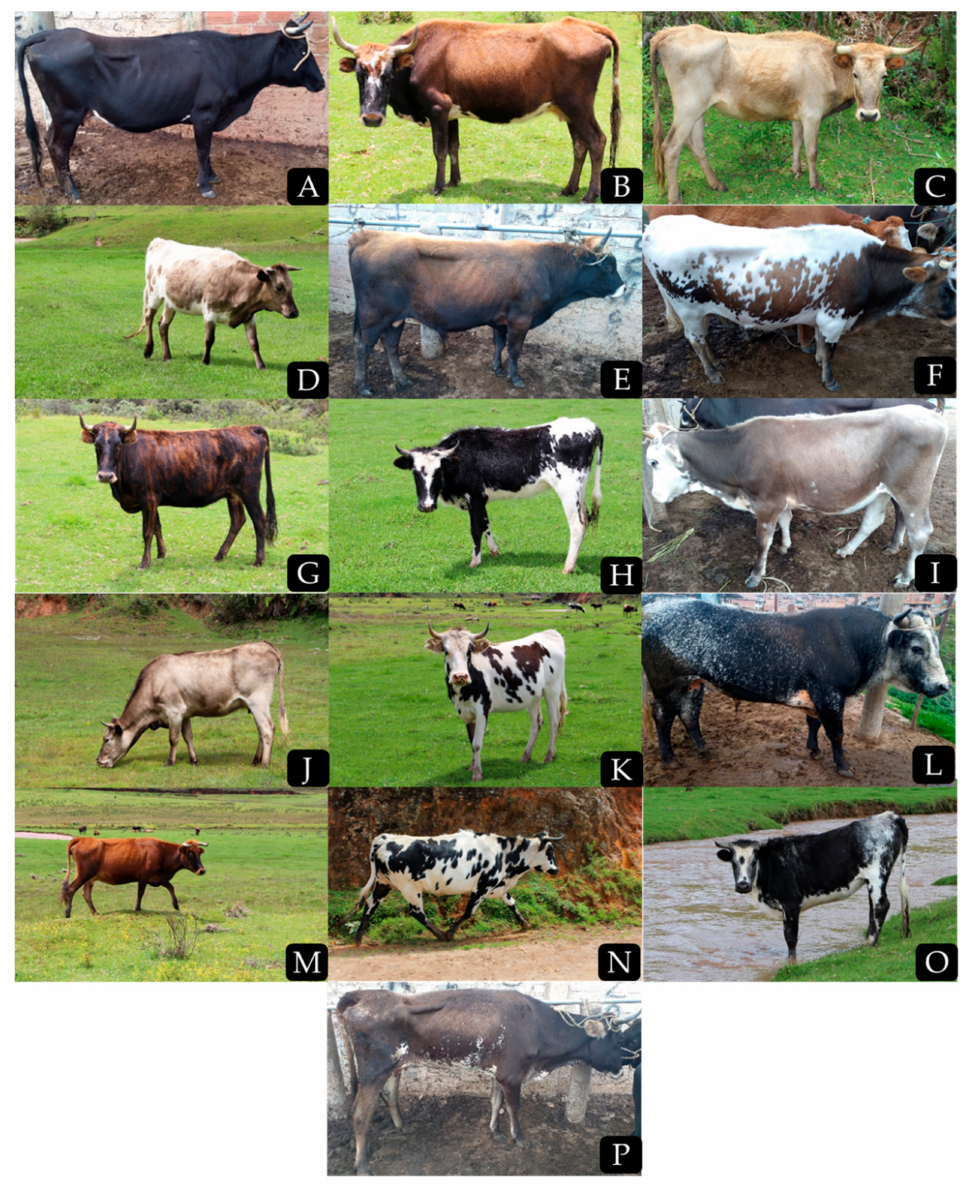
Figure 1. Coat coloring patterns of Creole cows from the southern Amazonas